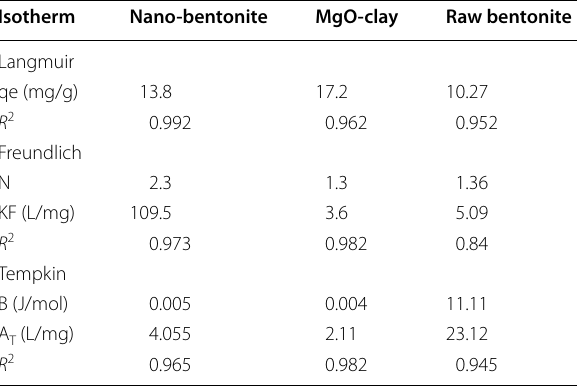
Table 7 Equilibrium isotherm modeling of MG adsorption onto adosorbents nano-bentonite, MgO impregnated clay and